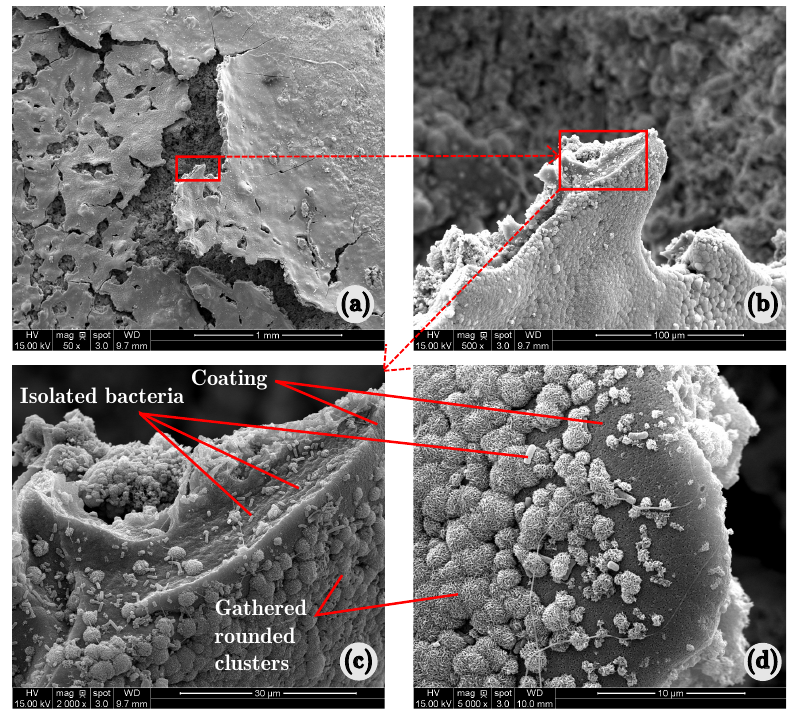
Figure 7. SEM images (secondary electron mode) of TiO 2 -coated samples irradiated with UV light for 24 h.